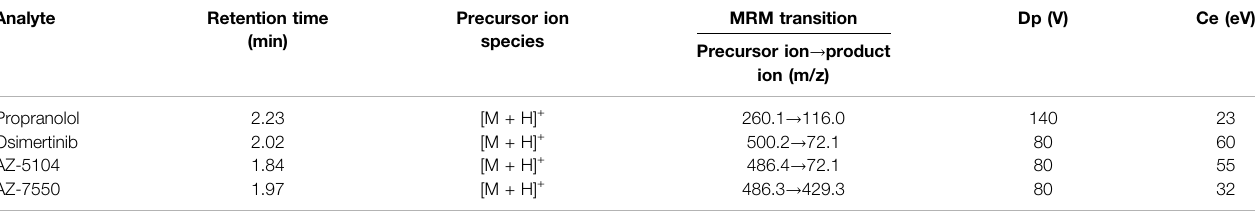
TABLE 1 | Optimized MRM parameters of the analytes and IS in this